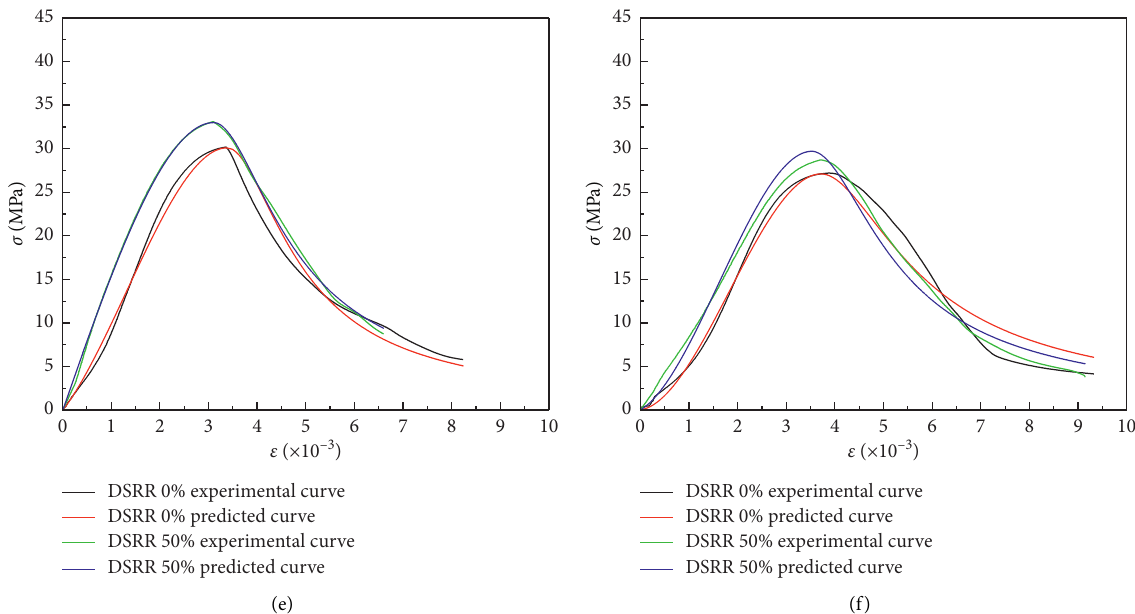
Figure 19: Comparison between predicted results and experimental results of OC and DSC with 50% DSRR under different freeze-thaw cycles. (a) 0 times. (b) 25 times. (c) 50 times. (d) 75 times. (e) 100 times. (f) 125 times.